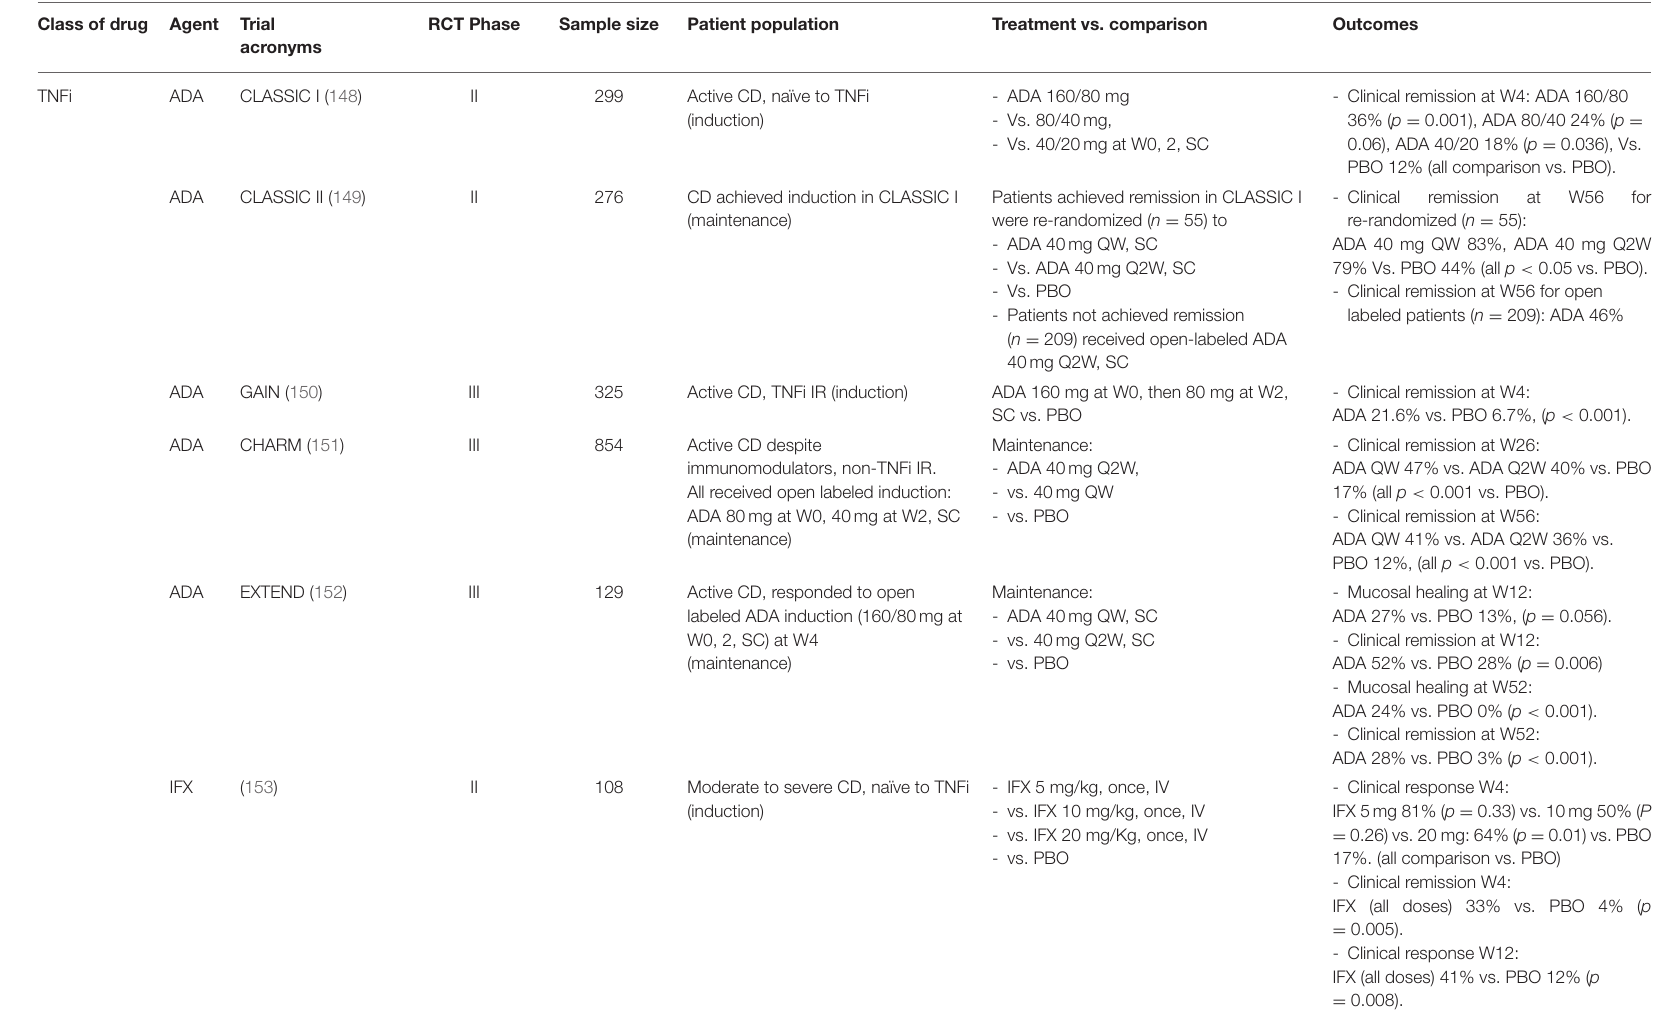
TABLE 2 | Evidence from major clinical trials for class of therapeutic options for Crohn’s